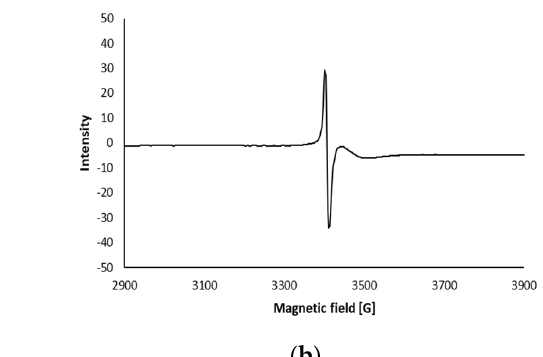
( b ) Figure 1. Electronic spin resonance ( ESR) spectrum of original deionized, non-treated water containing dissolved air ( a ) and WTS ( b ) after the 15 min treatment. In the case of deionized WST, ESR signals appeared after the 15 and 30 min treatments (Figure 2). The deionized WST water contained niches of larger size, hosting molecules of oxygen interacting with environment in various manners. That differentiation was reflected by broad resonance signals. Extended treatment time favoured an increase in the size of niches and further broadening of the signal. ( a ) ( b ) Figure 2. ESR spectra of deionized WST after the 15 ( a ) and 30 ( b ) min treatment.